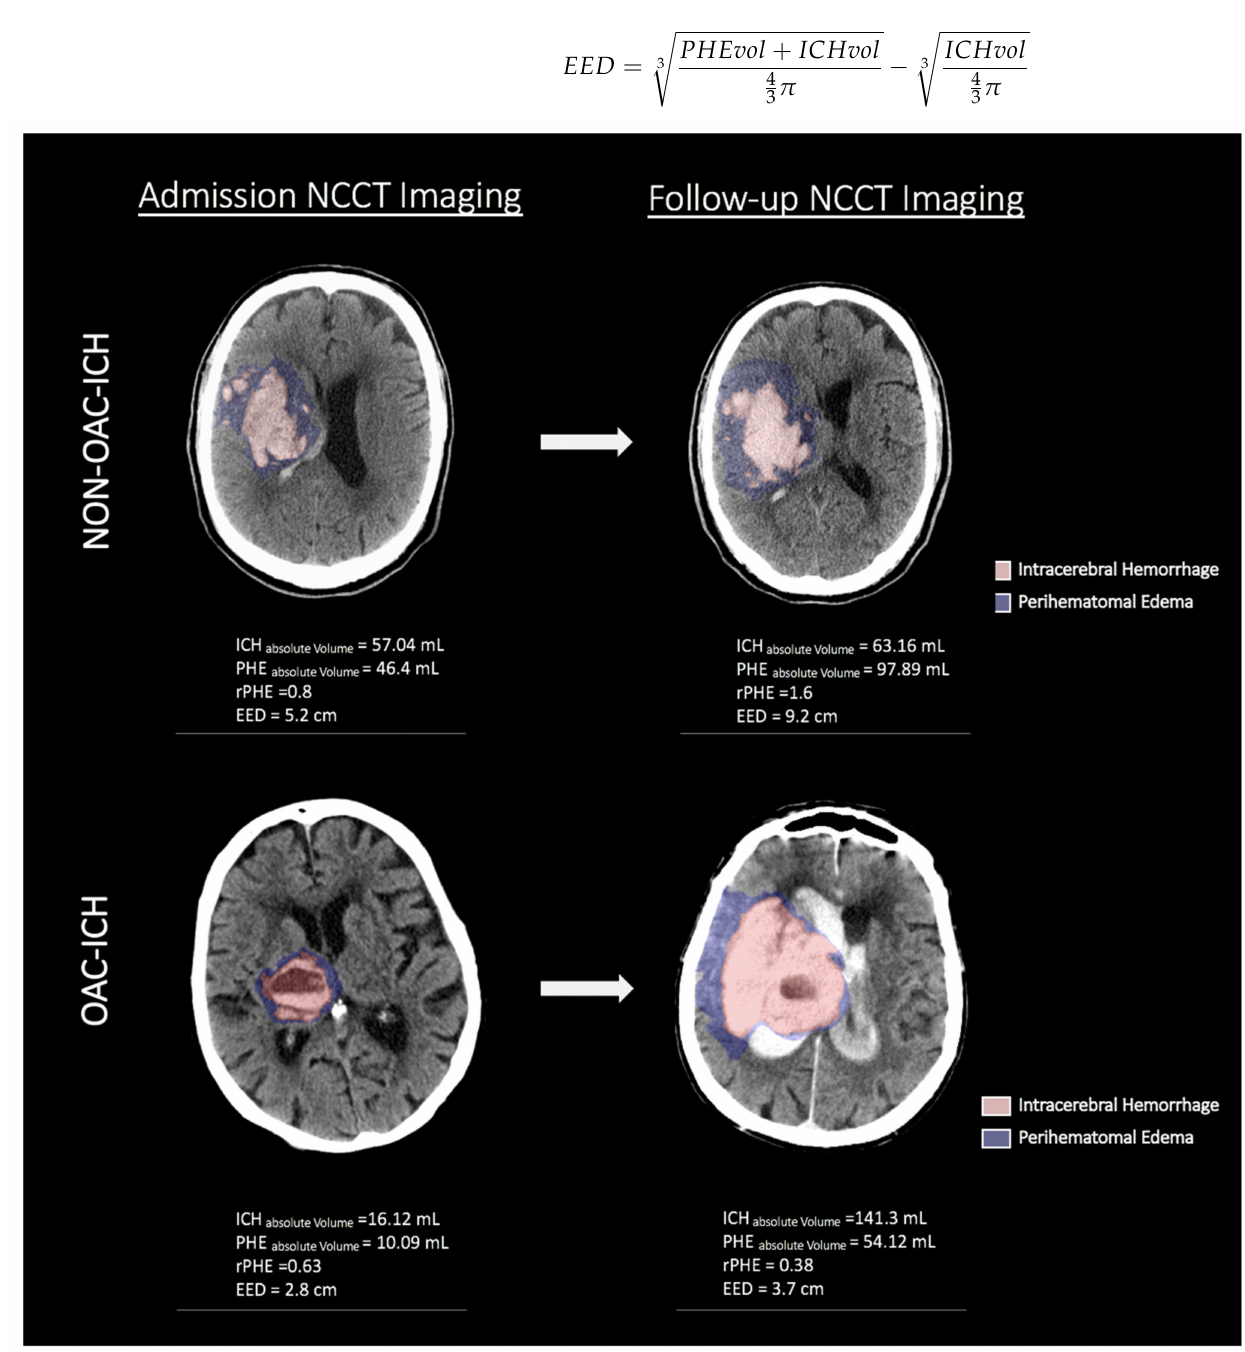
Figure 1. Illustrative examples of patients with spontaneous intracerebral hemorrhage (NON-OAC-ICH) and oral antico- agulation related intracerebral hemorrhage (OAC-ICH). Legend: ICH indicates intracerebral hemorrhage; EED, edema extension distance; NCCT, noncontrast computed tomography, OAC-ICH, OAC related intracerebral hemorrhage; PHE, perihematomal edema; rPHE, relative perihematomal edema; and NON-OAC-ICH, non-oral anticoagulation related intracerebral